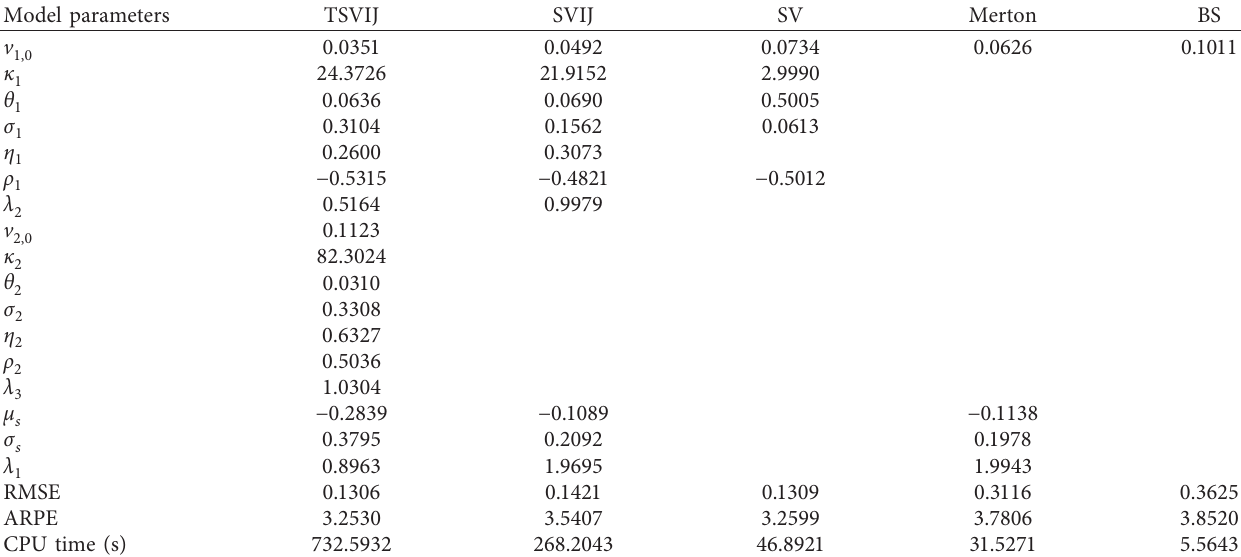
Table 5: Estimated risk-neutral parameters for five given